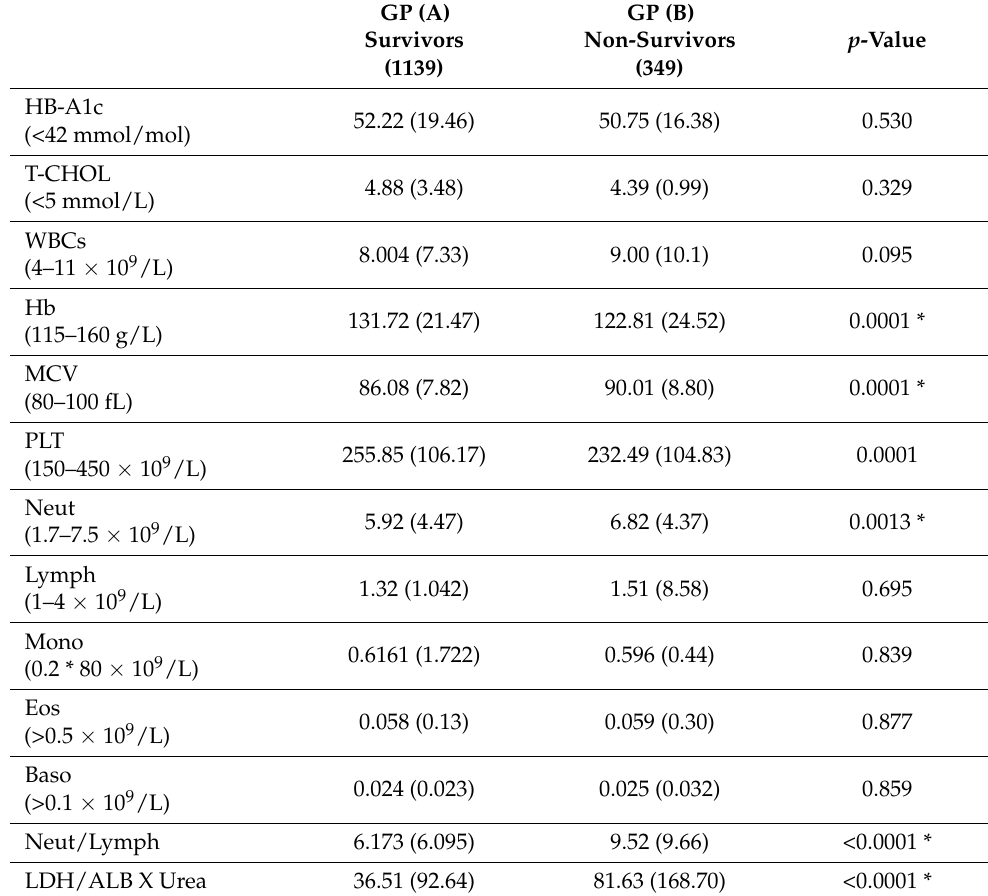
Table 2. Haematological Findings of the Study